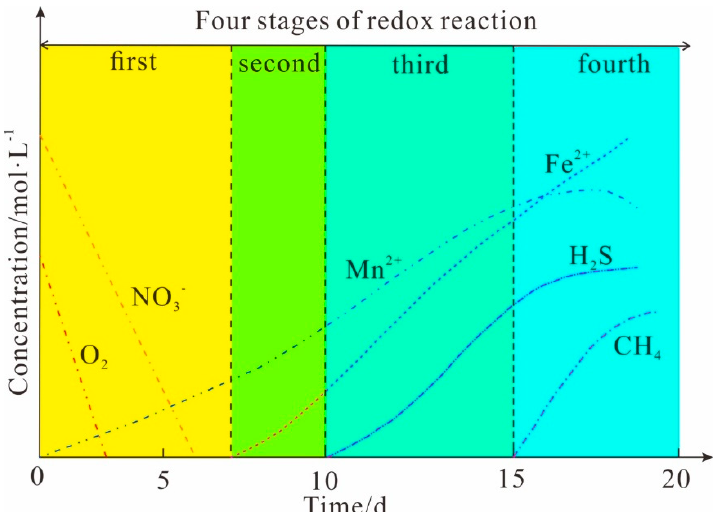
Figure 8. The theoretical sequence of the redox action after water infiltrating to soil [compiled from: 20].